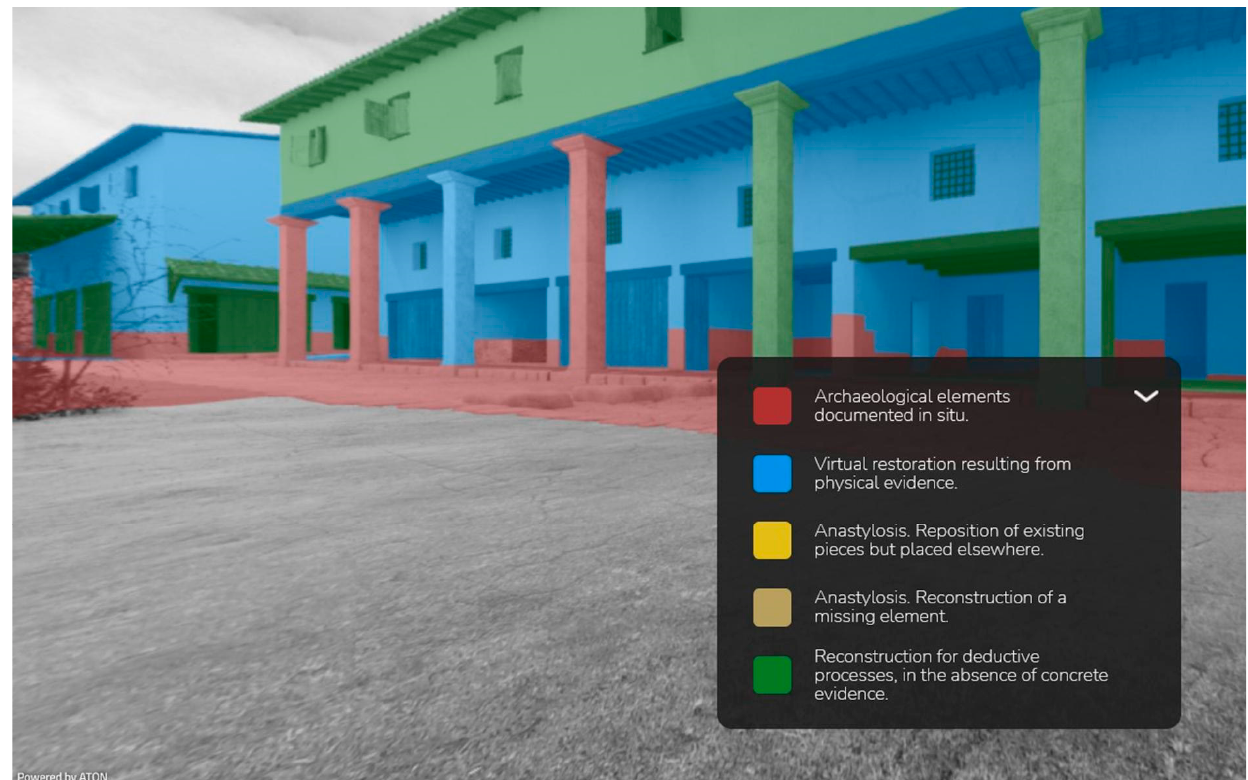
Figure 6. Example of scientific back-end mapping with reliability levels of the Alba Fucens recon- struction (by Hubstract Made for Art).